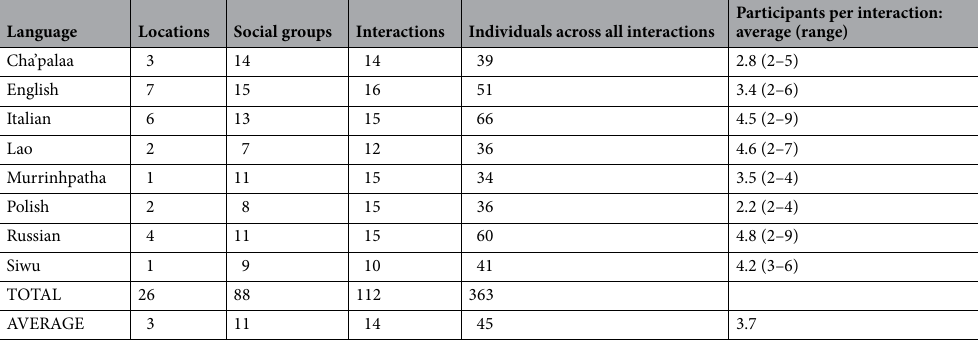
Table 5 shows two measures of inter-coder reliability—Krippendorff’s α 75 and simple percent agreement (PA)—